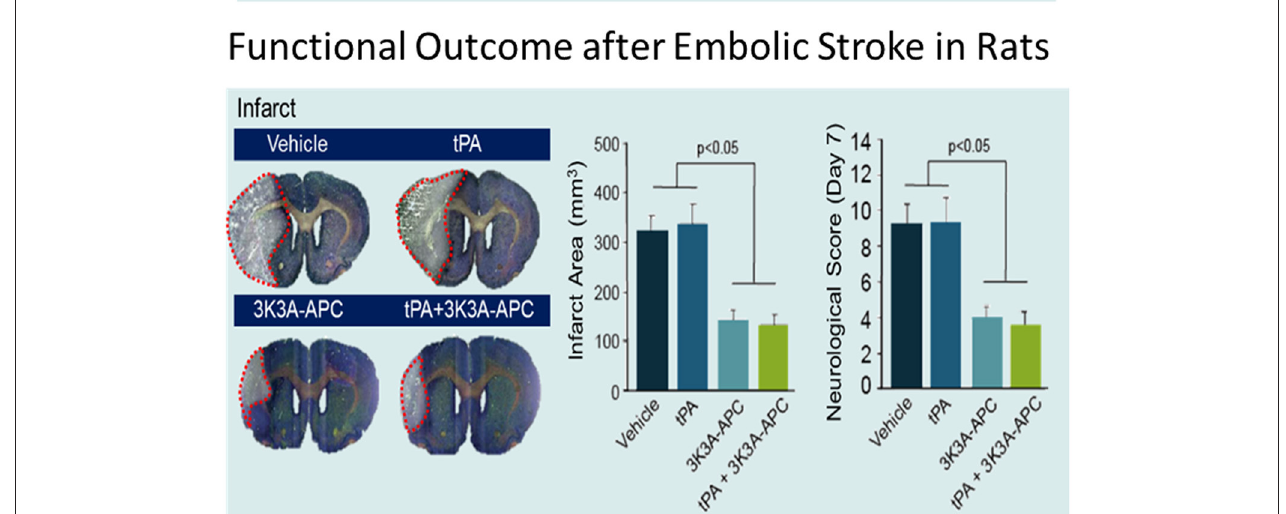
Frontiers in Neurology |